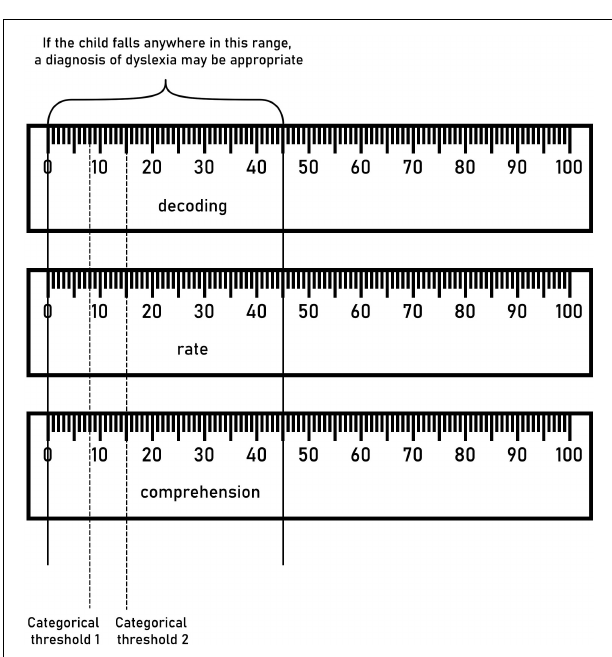
FIGURE 2 | Multicomponent assessment chart. A chart of this kind could be included in reading assessments to help clinicians define a